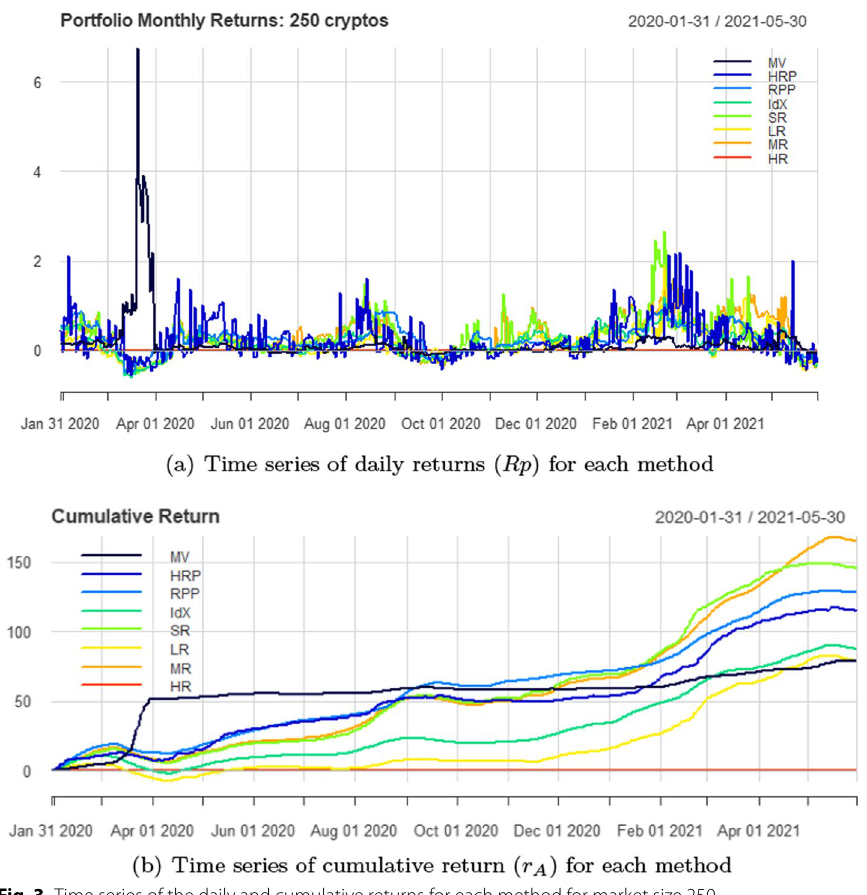
Fig. 3 Time series of the daily and cumulative returns for each method for market size